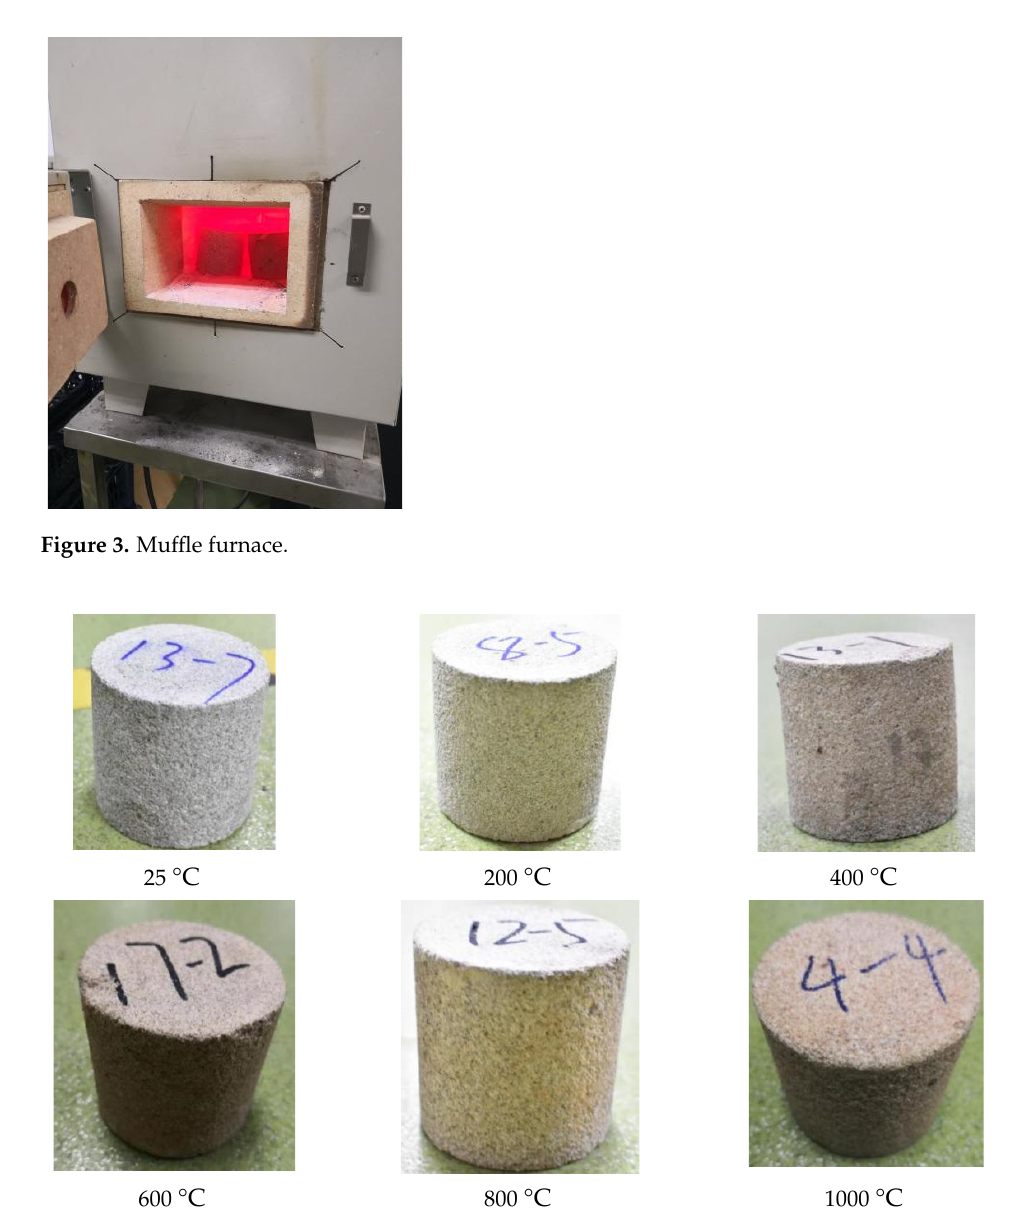
Figure 4. The appearance of sandstone specimens at different temperatures.